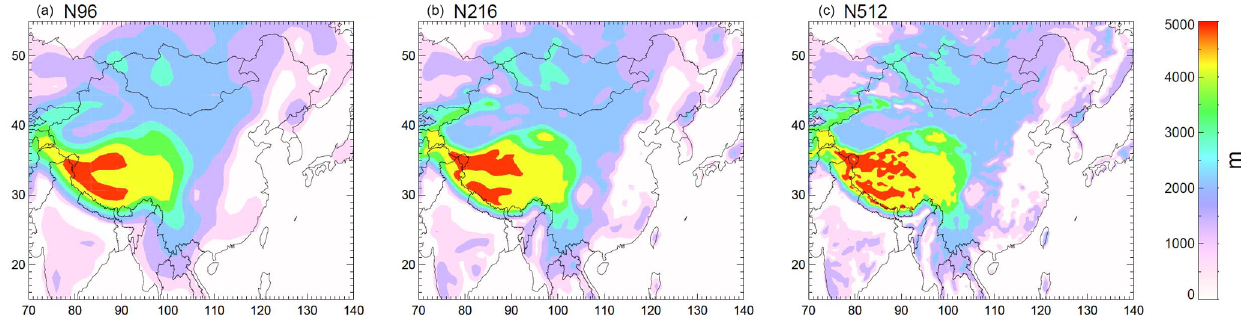
Figure 1. Grid-point mean orographic height for (a) N96, (b) N216 and (c) N512 horizontal